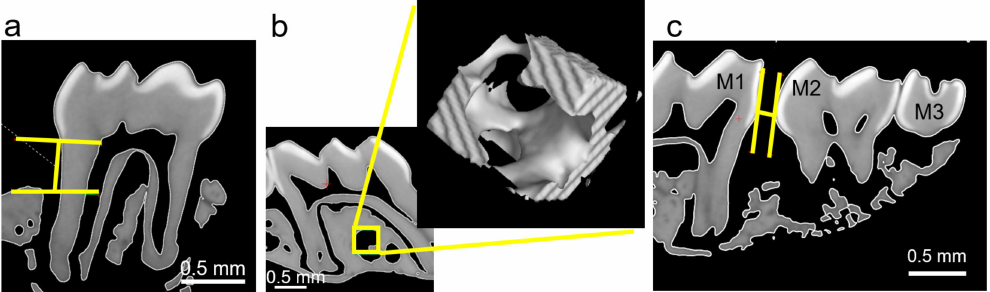
Figure 1. Assessment of periodontal bone loss using the calliper function ( a ), bone density by determining a region of interest (yellow box, ( b )), which was extracted and enlarged, and orthodontic tooth movement using the calliper funtion ( c